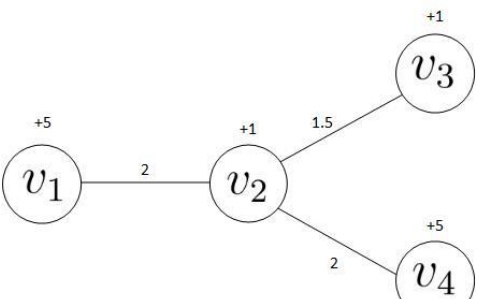
Fig. 1. The optimal solution of backup 2-maxian problem contains no both two ends of longest path of the tree.